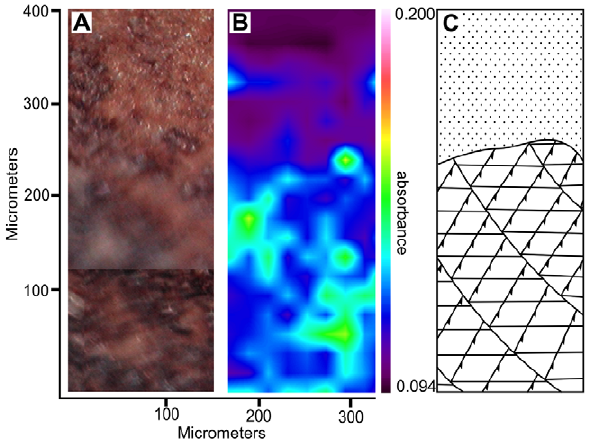
Figure 4. Infra-red absorption map of Gansus yumenensis barbules with corresponding visual image and diagram. (A) Optical microscope image of a section of barbules of a Gansus yumenensis feather (MGSF317) in reflected light, approximate position on the feather denoted by the yellow dot in figure 1B. (B) A map of infra-red absorption of the carboxylic acid C=O symmetric stretch at 1415 cm -1 of the whole optical image taken in ATR mode. (C) A diagrammatic interpretation of (A) shows the separation of feather barbules (bottom) and sedimentary matrix (top) to guide the eye.